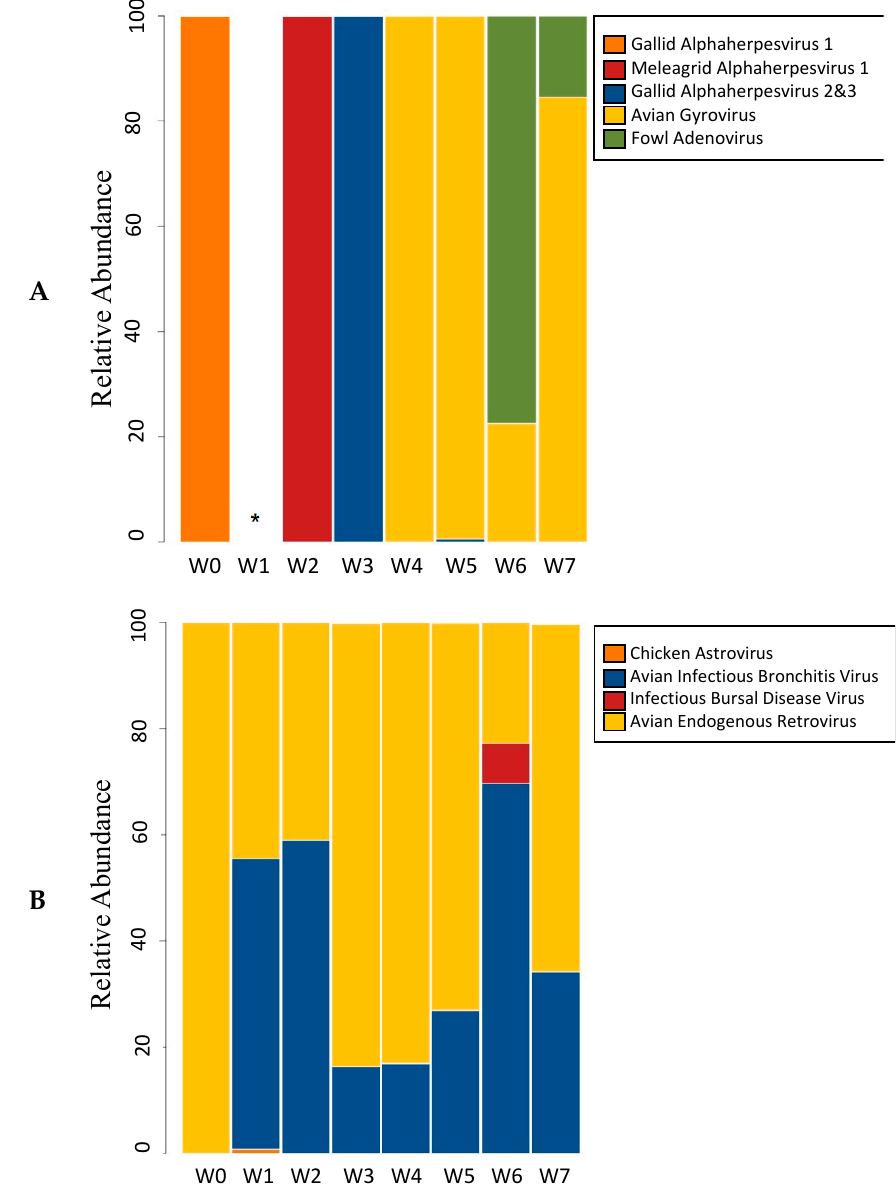
Figure 1. Normalized relative abundance of detected DNA ( A ) and RNA ( B ) viral species at each time point. * No DNA viruses detected at Week 1.